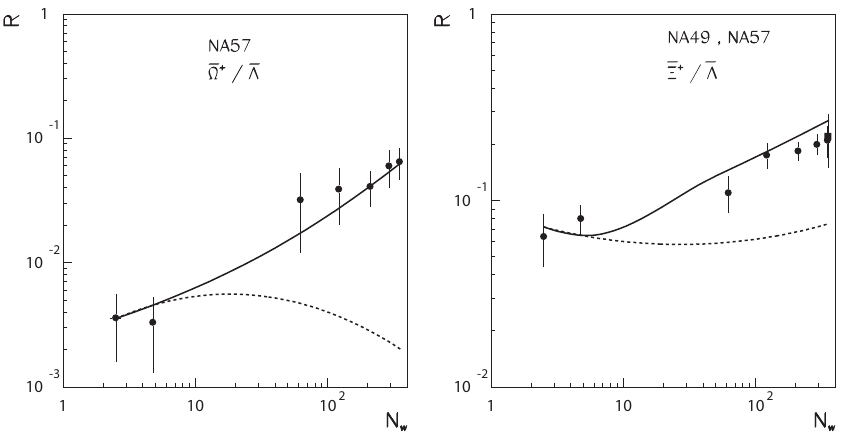
+ / Λ + / Λ Figure 1. Ratios of Ω (left panel), and of Ξ (right panel) as functions of the number of wounded nucleons, N w . The experimental data of Pb + Pb collisions for di ff erent numbers of wounded nucleons, N w (di ff erent centralities) measured by the NA57 Collaboration (points), and by the NA49 Collaboration (squares) are presented, and compared with the corresponding QGSM